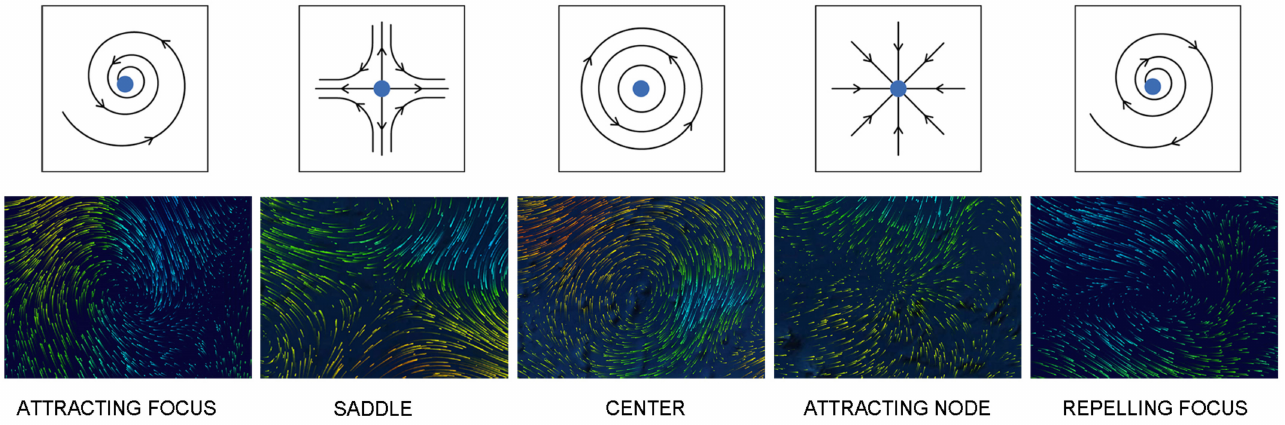
Figure 10. Flow feature representation